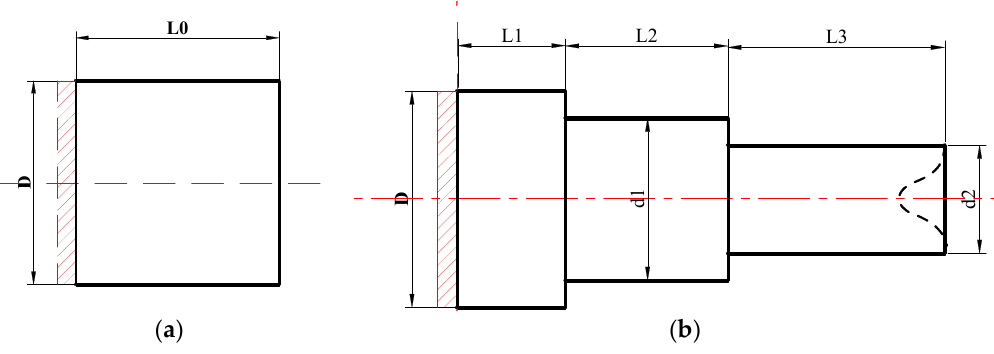
Figure 4. Diagrams of traditional billets and product: ( a ) traditional billet; ( b ) rolled piece.